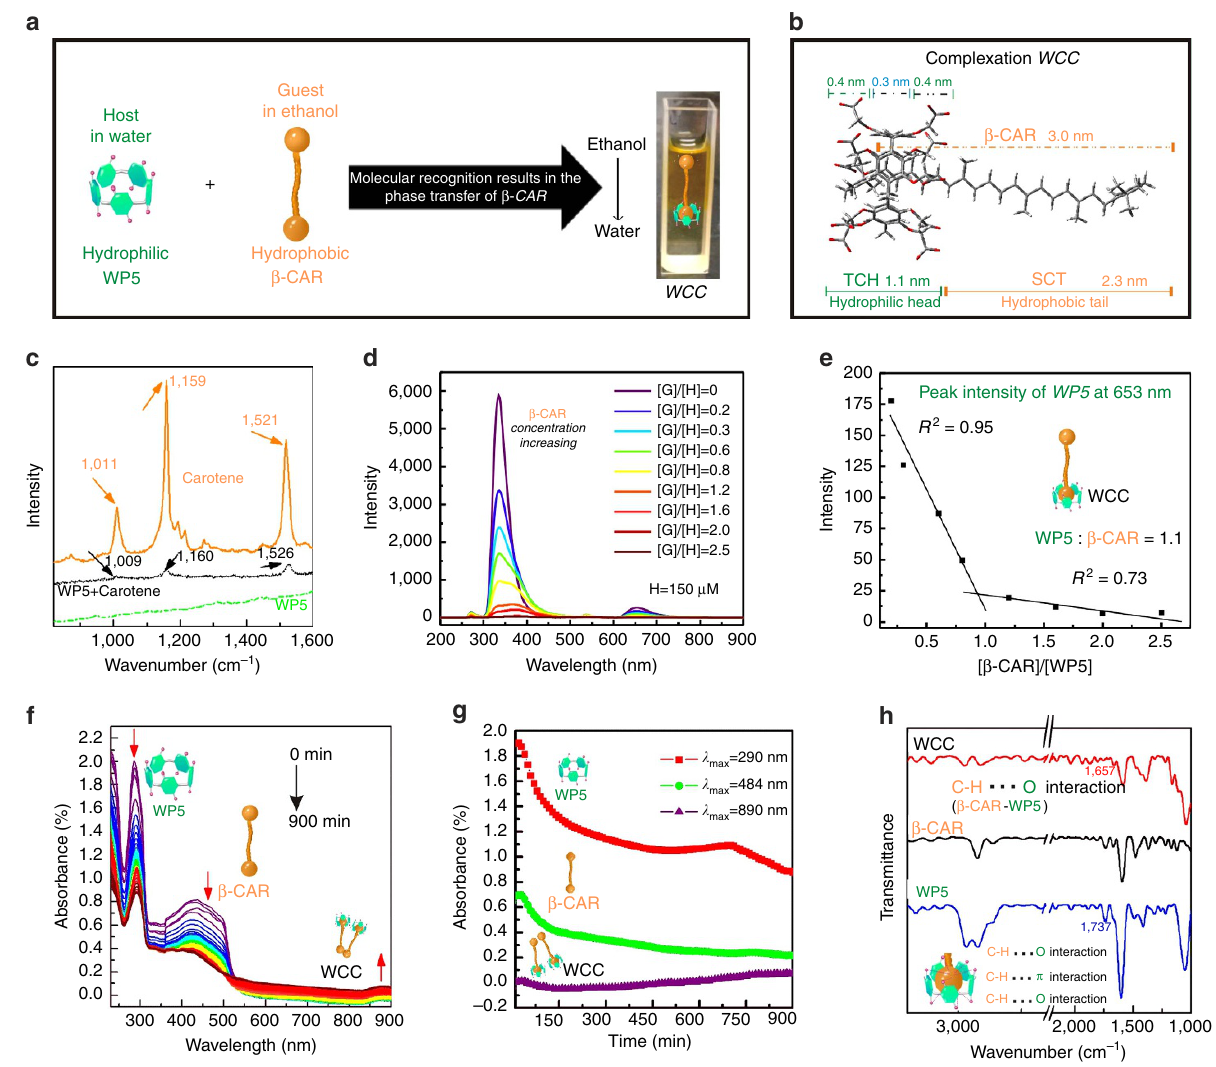
Figure 2 | Synthesis of the WCC. ( a ) A schematic displaying the synthetic route to the WCC. ( b ) Simulated structure of the WCC. ( c ) Raman spectra of b -CAR and the WCC. ( d ) Fluorescence spectra of WP5 (150 m M) on addition of b -CAR in ethanol/water (excited at 268nm) at room temperature. ( e ) The fluorescence intensity changes of WP5 at 653nm. ( f ) Time-dependent ultraviolet–visible spectra showing the formation of the WCC, as indicated by the changes in the intensities of the peaks at 290 and 484nm (20min each). ( g ) Plot of absorbance intensity as a function of time (20min each). ( h ) FT-IR spectra of WP5, b -CAR and the